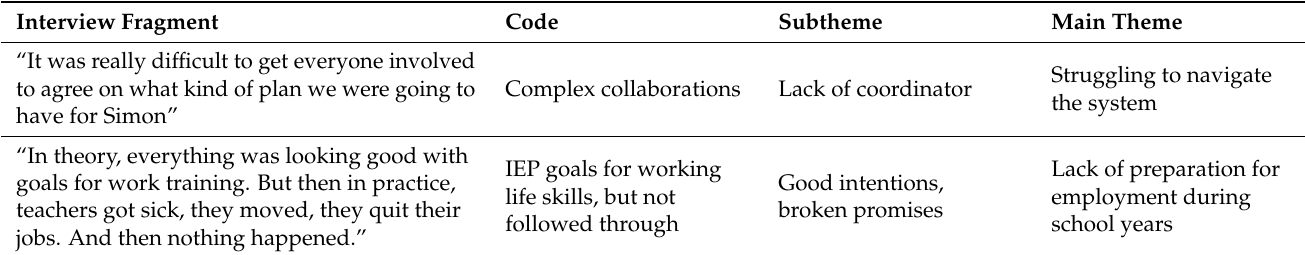
Table 1. Example of data analysis